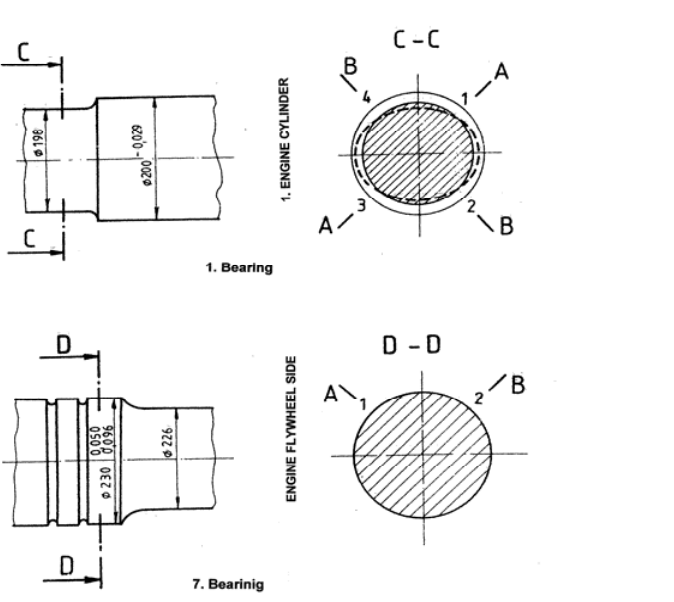
Figure 9 – Display of the measuring points with the positions of the probes for measuring the dynamic paths of the main